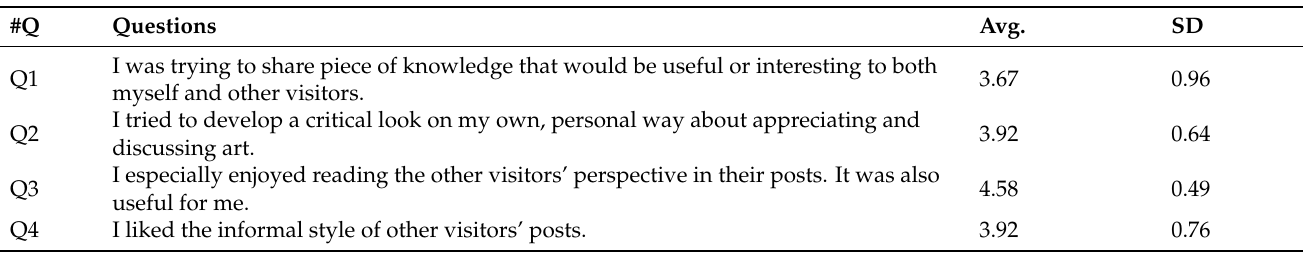
Table 8. Questions and average ratings of participants’ attitude concerning the potential of the